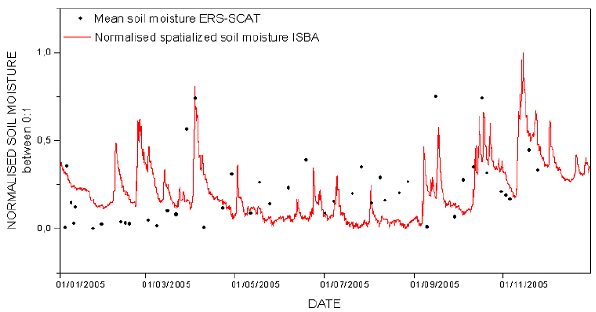
Fig. 9. Comparison between surface soil moisture ERS-SCAT (black stars) and spatialized soil moisture mean from ISBA (red line). The soil moisture data are representative over 2cm